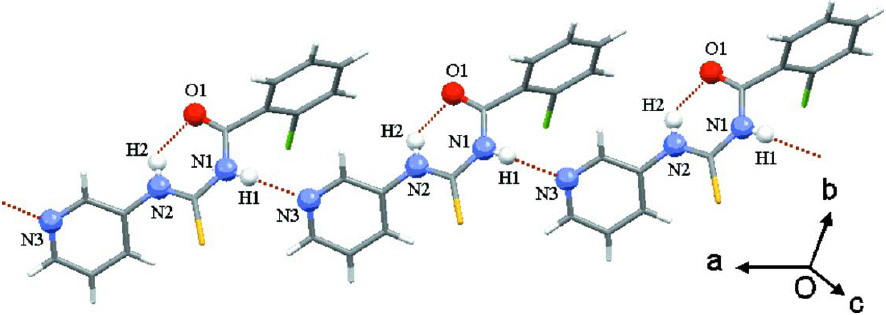
The molecule structure of the title compound with atom numbering. Displacement ellipsoids for non-hydrogen atoms are drawn at the 30% probability level.